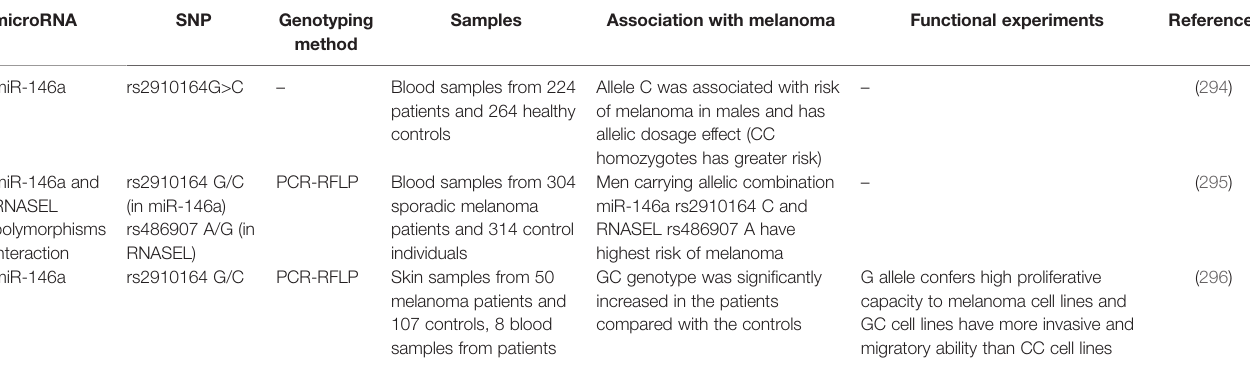
TABLE 6 | Summary of studies which assessed association between miRNA polymorphisms and risk of